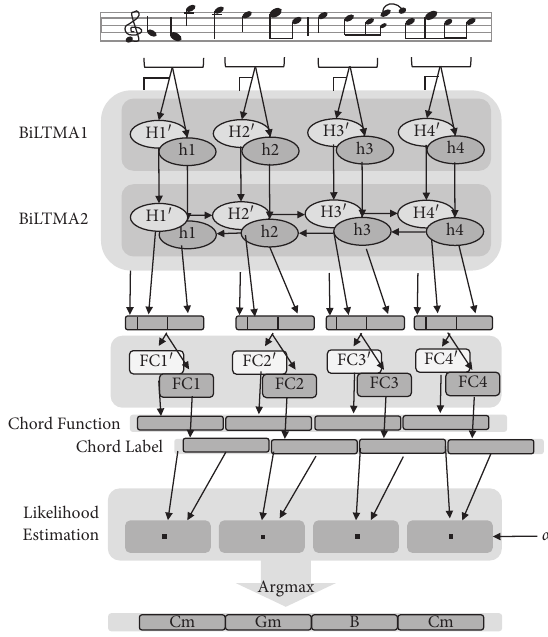
Figure 1: Diagram of the proposed MTHarmonizer, a deep multitask model